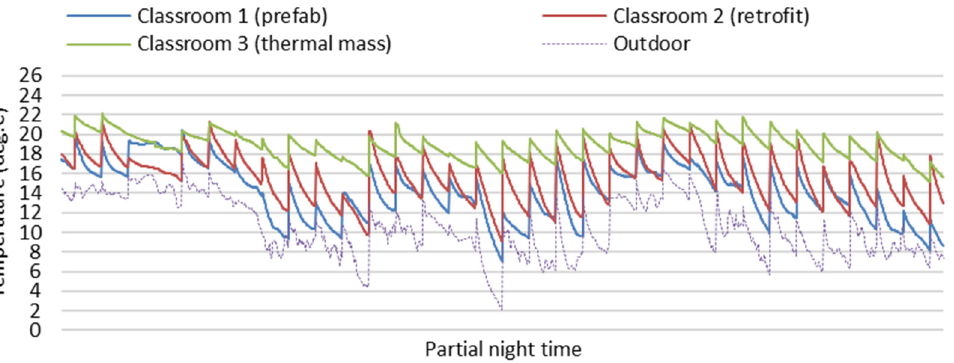
Figure 8. Field study data of indoor temperature of the three classrooms during winter nights (7 p.m. to 7 a.m.).